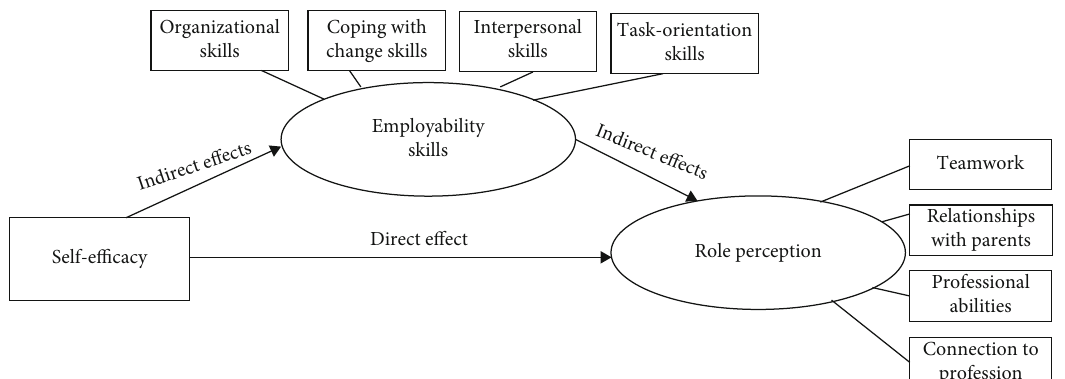
Figure 1: Self-e ffi cacy, employability skills, and role perception conceptual